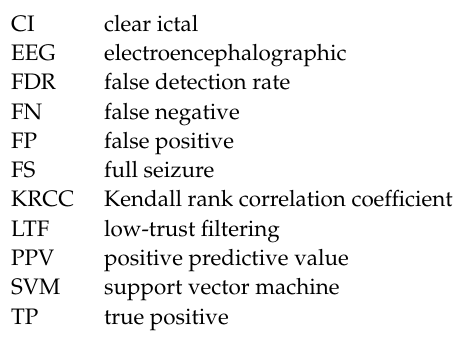
detection after low-trust filtering for the CI SVM. Table S1: Mean (standard deviation) performances of: CI SVM and LTF with trust models trained on the FS (trust FS) labels, with the percentage of segments filtered being either patient-independent or patient-dependent. Table S2: Mean (standard deviation) performances of: CI SVM and LTF with trust models trained on the CI (trust CI) labels, with the percentage of segments filtered being either patient-independent or patient-dependent, Table S3: Mean (standard deviation) performances of: CI SVM and LTF with the confidences of this SVM (CI SVM conf.), with the percentage of segments filtered being either patient-independent or